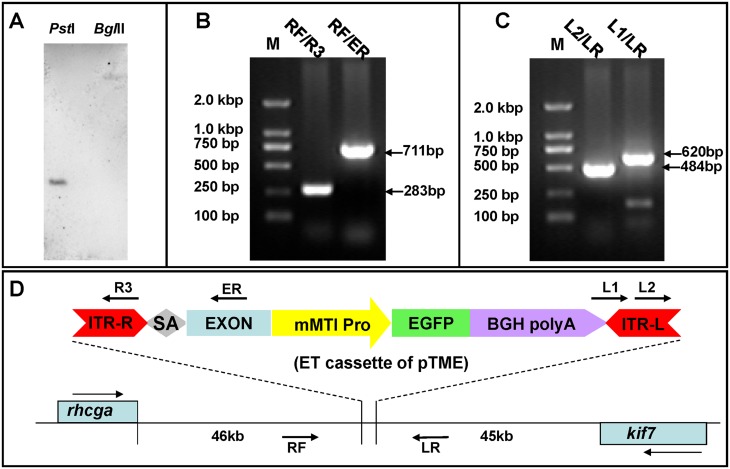
Molecular characterization of genetic background in ET line pTME12.
(A) Southern blotting for analysis of ET cassette copy number in line pTME12. The genomic DNA was extracted from F2 embryos and digested with PstI and BglII. (B and C) Analysis of an ET cassette in line pTME12. Genomic DNA from F2 embryos was prepared as a template for PCR analysis using primers indicated in (D). (D) The sketch of ET cassette location in zebrafish genome. The insertion is located about 46 kb downstream of rhcga and about 45 kb downstream of kif7. Arrows on top of rhcga or under kif7 indicate transcriptional direction of these genes. The positions of primers used for molecular analysis are showed in the diagram.